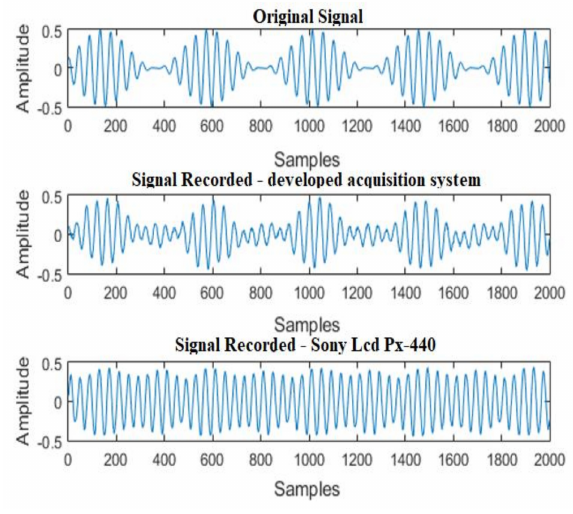
Figure 18. Acquisition of an AM signal—carrier: 1 kHz/modulator: 100 Hz.